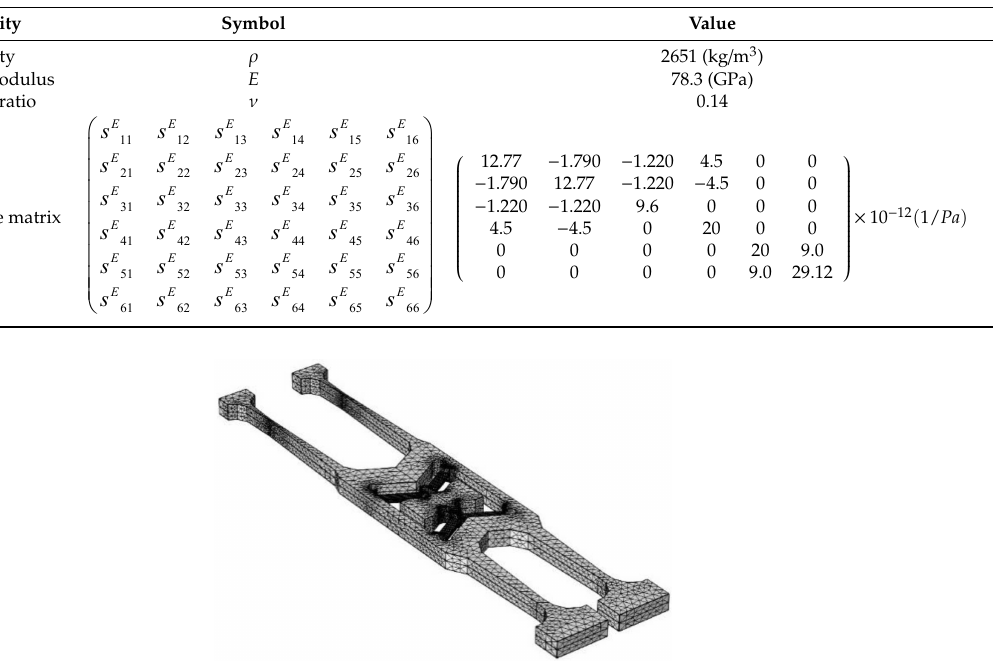
Figure 13. Meshing of the gyroscope model. Table 1. Quartz crystal parameters. Table 1. Quartz crystal parameters.